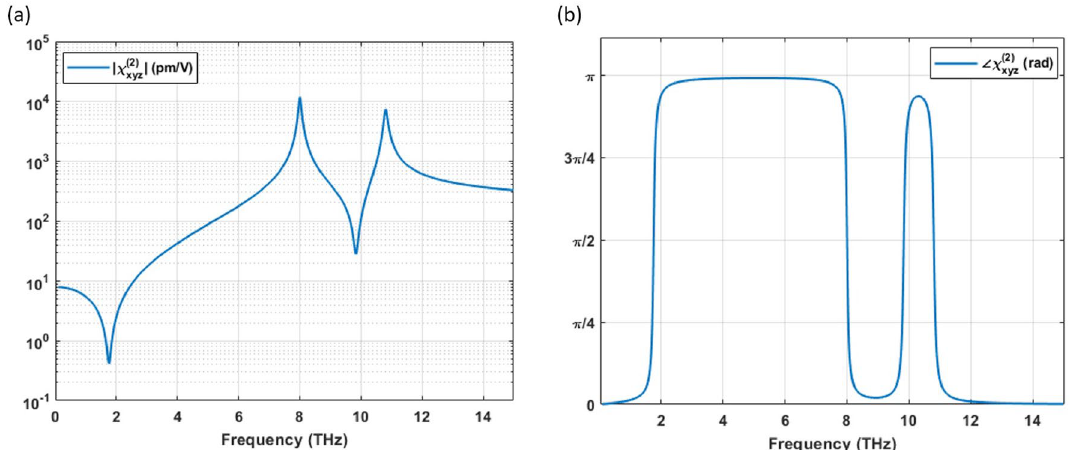
( 2 ) , ω 2 , − ω 1 ) of AlGaAs in the THz region: ( a ) magnitude and ( b ) xyz (ω 3